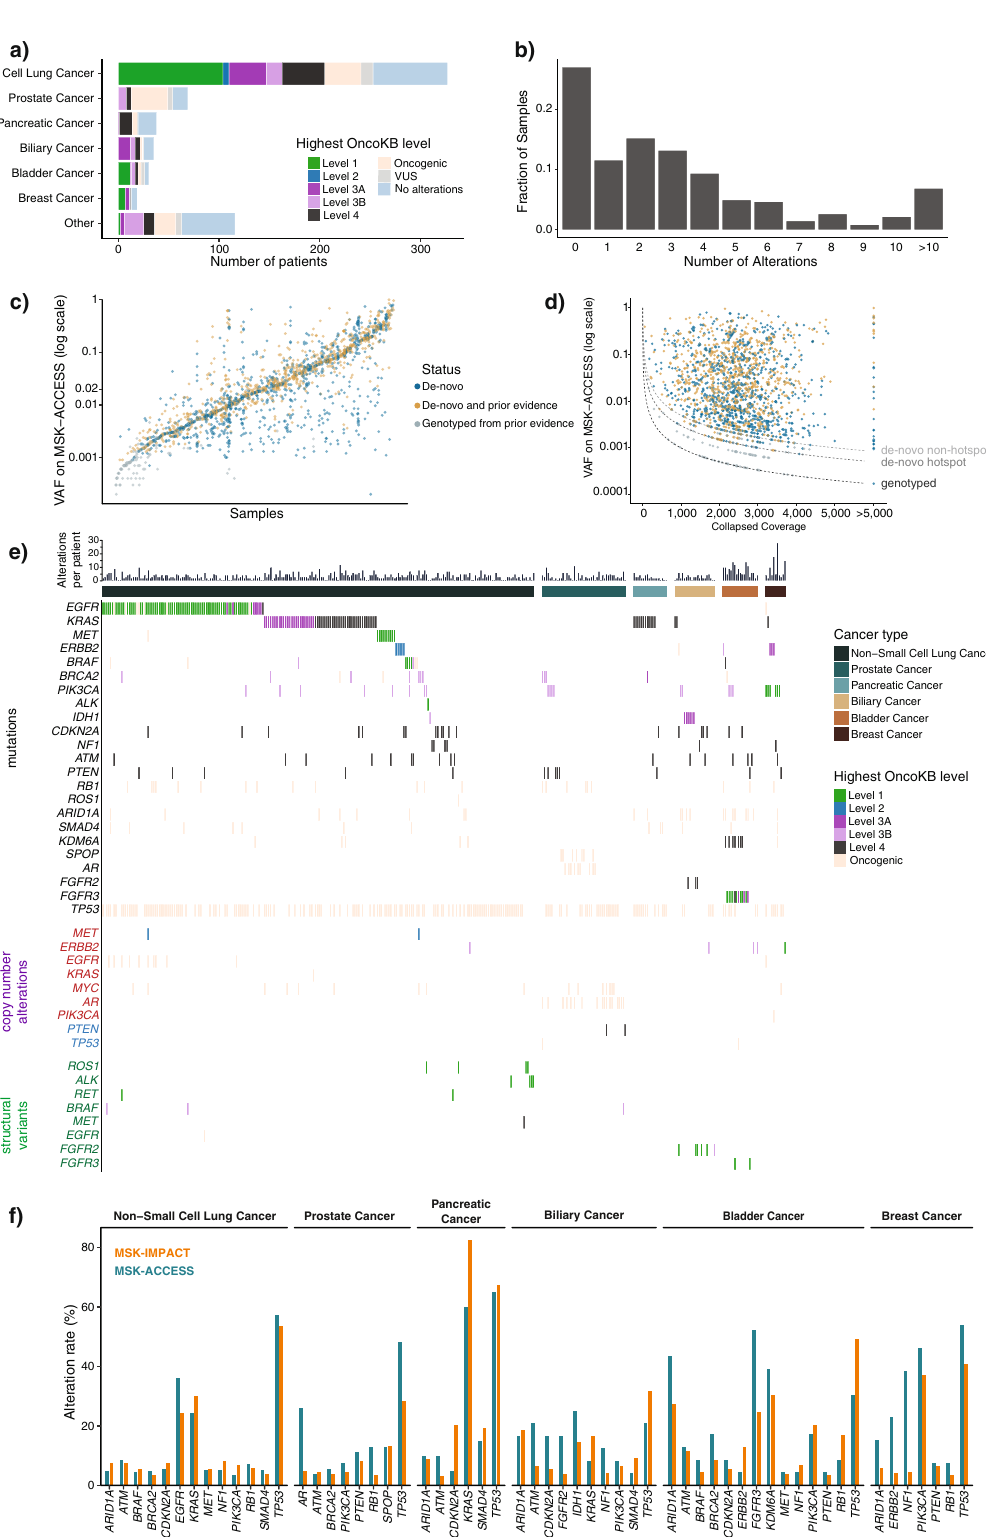
had clinical MSK-IMPACT results from 520 sequenced tumor tissues. A total of 1206 mutations were reported in the over- lapping target regions across both assays, and 59% ( n = 706) of the mutations were reported by both assays (Fig. 3a). The dis- tribution of allele frequencies in tissue was slightly higher for the shared mutations than for the MSK-IMPACT-only calls ( p = 2.06 × 10 − 18 ), but this effect was not observed for